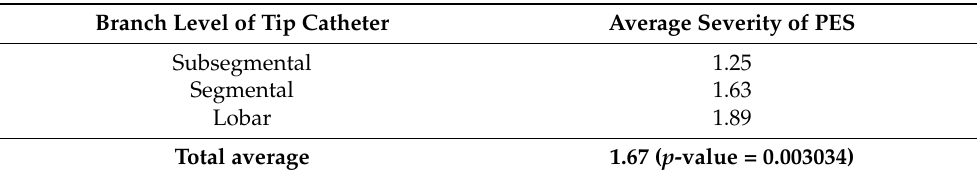
Table 4. Branch level of catheter tip with average severity of postembolization syndrome (PES; on a Scheme 0) compared using Pearson’s Chi-squared test (significance at p < 0.05).